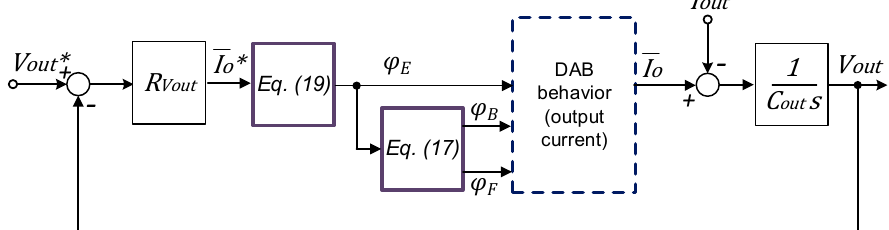
Figure 6. Control schematic for the SPS modulation.